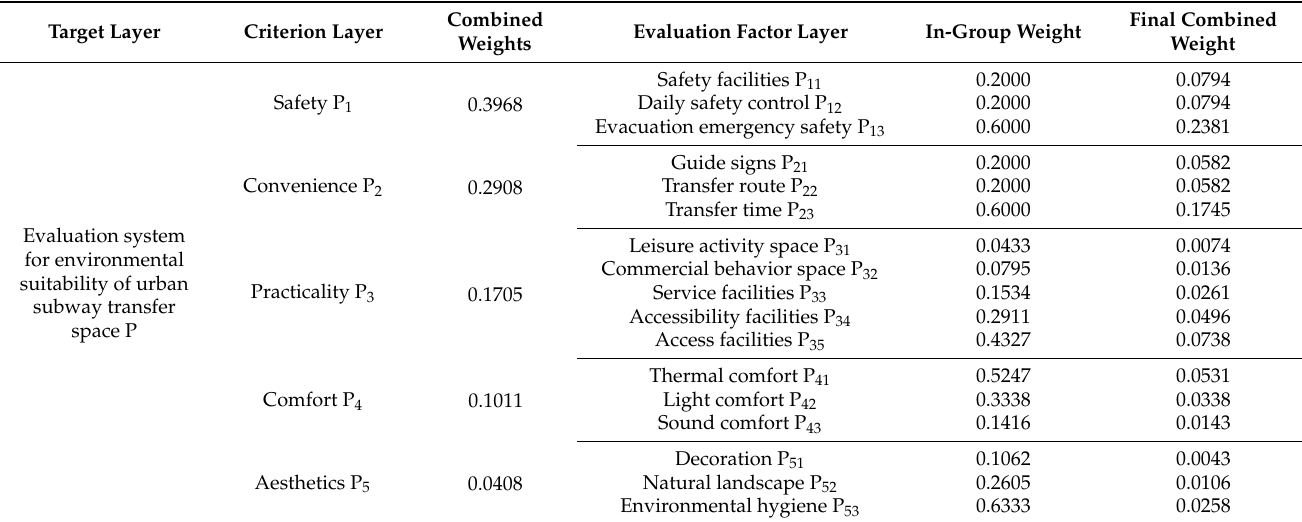
Table 4. Summary of weights of indicators at all levels.